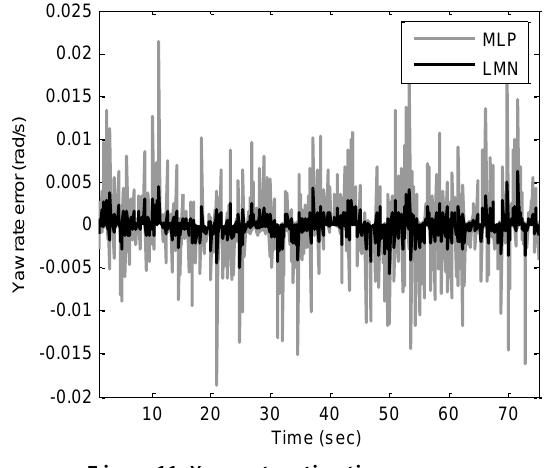
Figure 11. Yaw rate estimation error. Table 4. Results of yaw rate